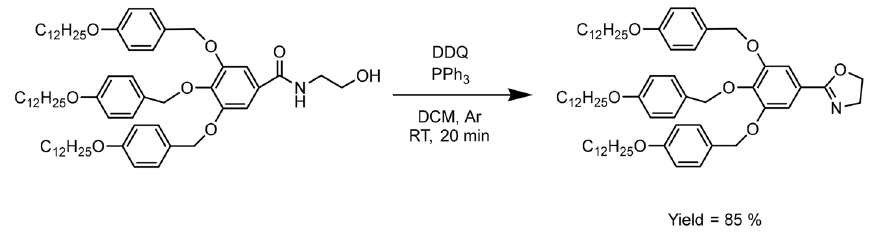
Figure 5. Synthesis of 2-(3,4,5-tris(4-dodecyloxybenzyloxy)phenyl)-2-oxazoline (TAPOx).